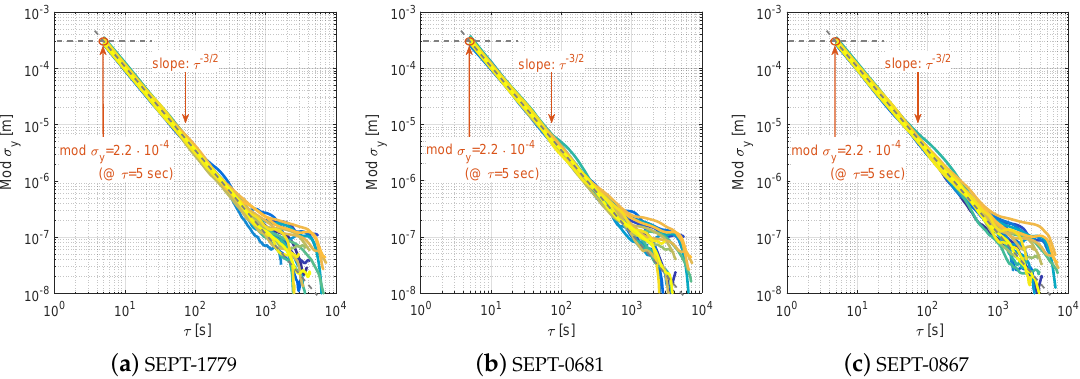
Figure 10. Modified Allan Standard Deviation shown for different GNSS receiver combinations to analyse the stochastic characteristics of the DD carrier phase observables form a zero baseline for the signal GL1C (GPS) on DOY067,